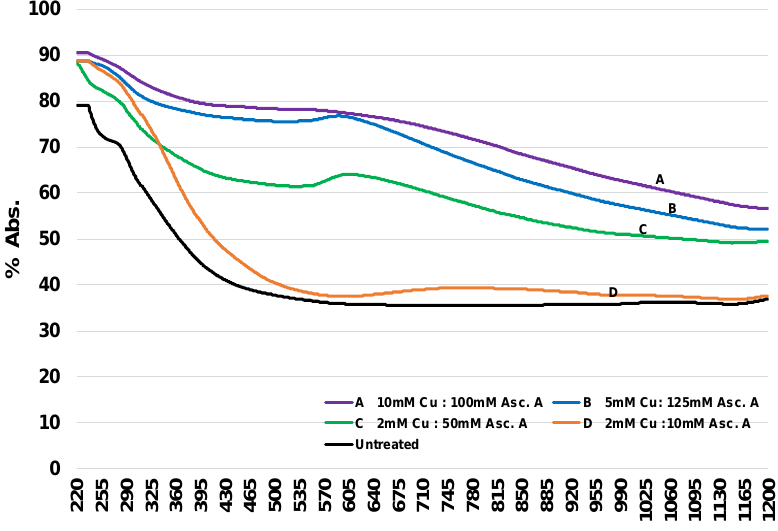
Figure 1. Solid UV/Vis spectra of hydroentangled 100% greige cotton with in situ copper nanoparticles ( A – C ) and adsorbed ( D ). Spectra ( A – C ) were pretreated with NaOH, treated with different concentrations of copper chloride solution, and reduced with ascorbic acid. Spectrum D was pad-dry treated with copper chloride in an ascorbic acid solution. The copper nanoparticle (CuNP) fabric samples exhibited a characteristic localized surface plasmon resonance peak at ~580 mn and the adsorbed sample copper oxide at ~800 nm.